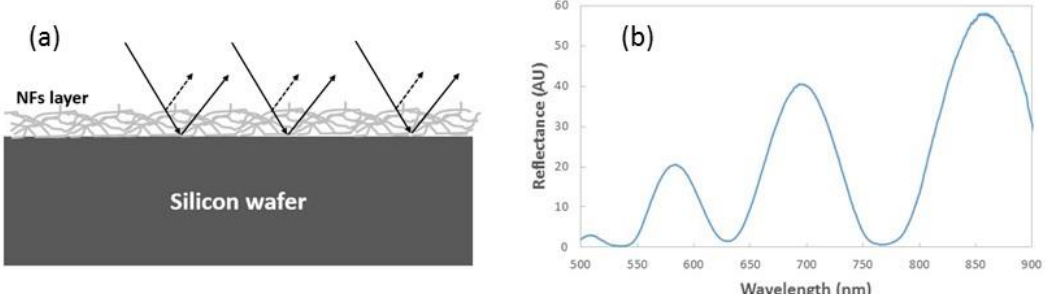
Figure 2. ( a ) Schematic diagram of a Fabry – Pérot (FP) NFs interferometer. ( b ) Reflectance spectrum of a polyamide 6 (PA6) NFs layer with a thin (~3 nm) gold layer deposited on top.